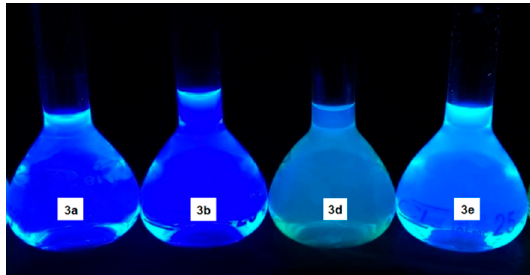
Figure 4 . Photograph of fluorescence of compounds 3a , 3b , 3d , and 3e in 0.1 M H 2 SO 4 at a concentration of 10 − 4 M under UV (365 nm) light.